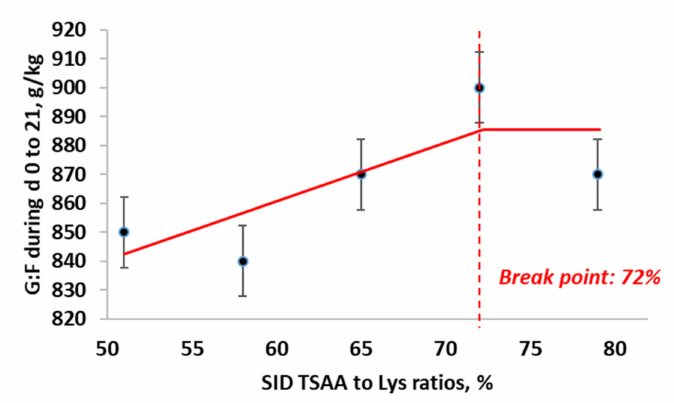
Figure 4. Broken-line linear ascending model for estimation of optimal SID TSAA to Lys ratio in nursery pigs under ABF for gain to feed from d 0 to 21.